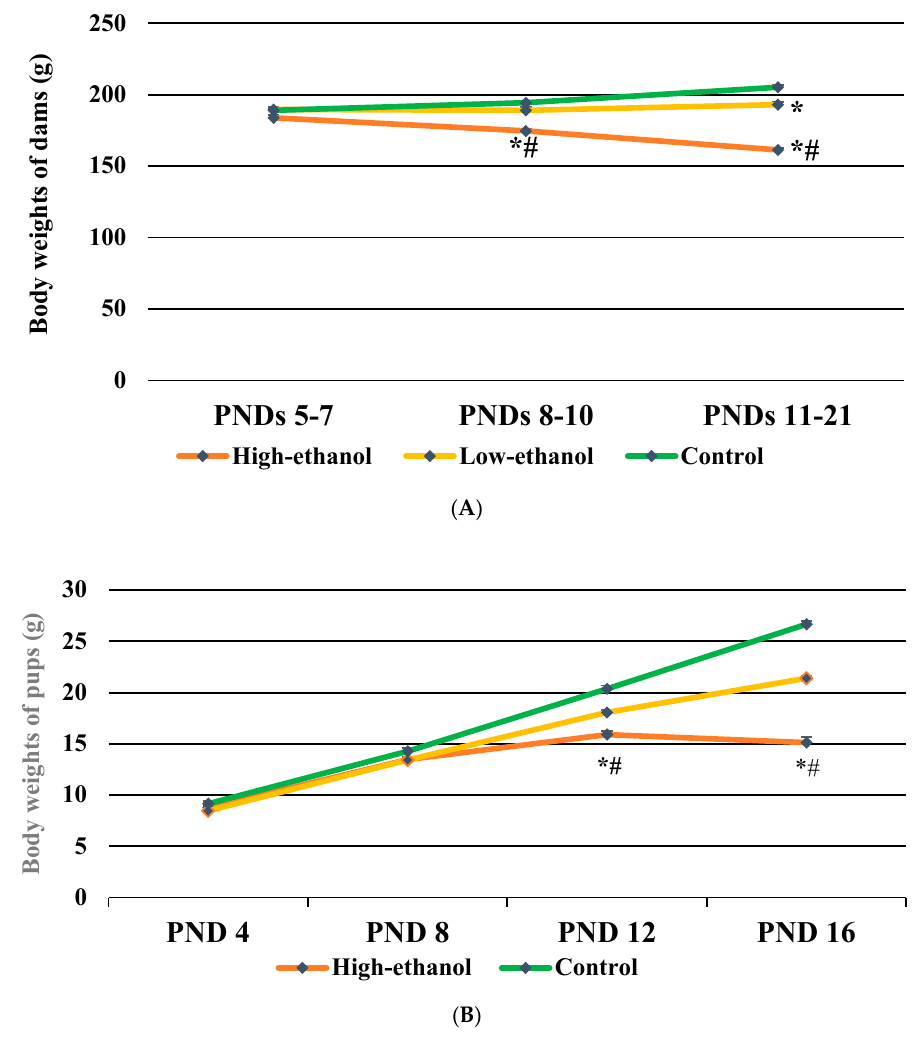
Figure 2. ( A ) Effects of ethanol exposure during lactation on body weights of dams; ( B ) Effects of ethanol exposure during lactation on body weights of rat pups; Data are expressed as the mean ± SEM; * p < 0.05 compared with that in the control dams and control pups, # p < 0.05 compared with that in the low ‐ ethanol dams and low ‐ ethanol pups; the number of dams was 6 in each of the three groups; the number of pups was 10 (5 males and 5 females) in each of the three groups.